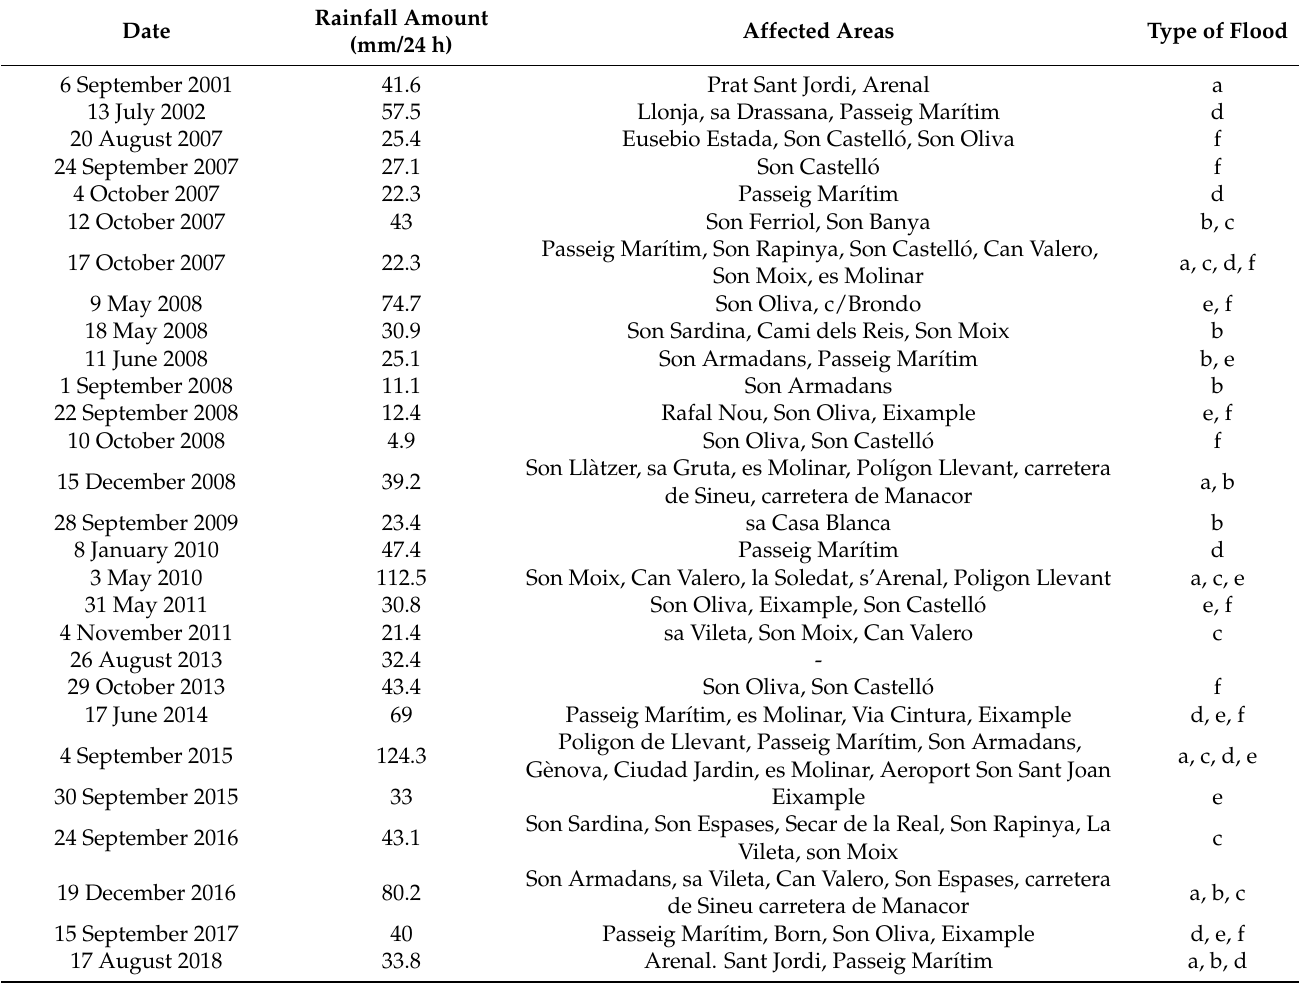
Table 4. List of flood